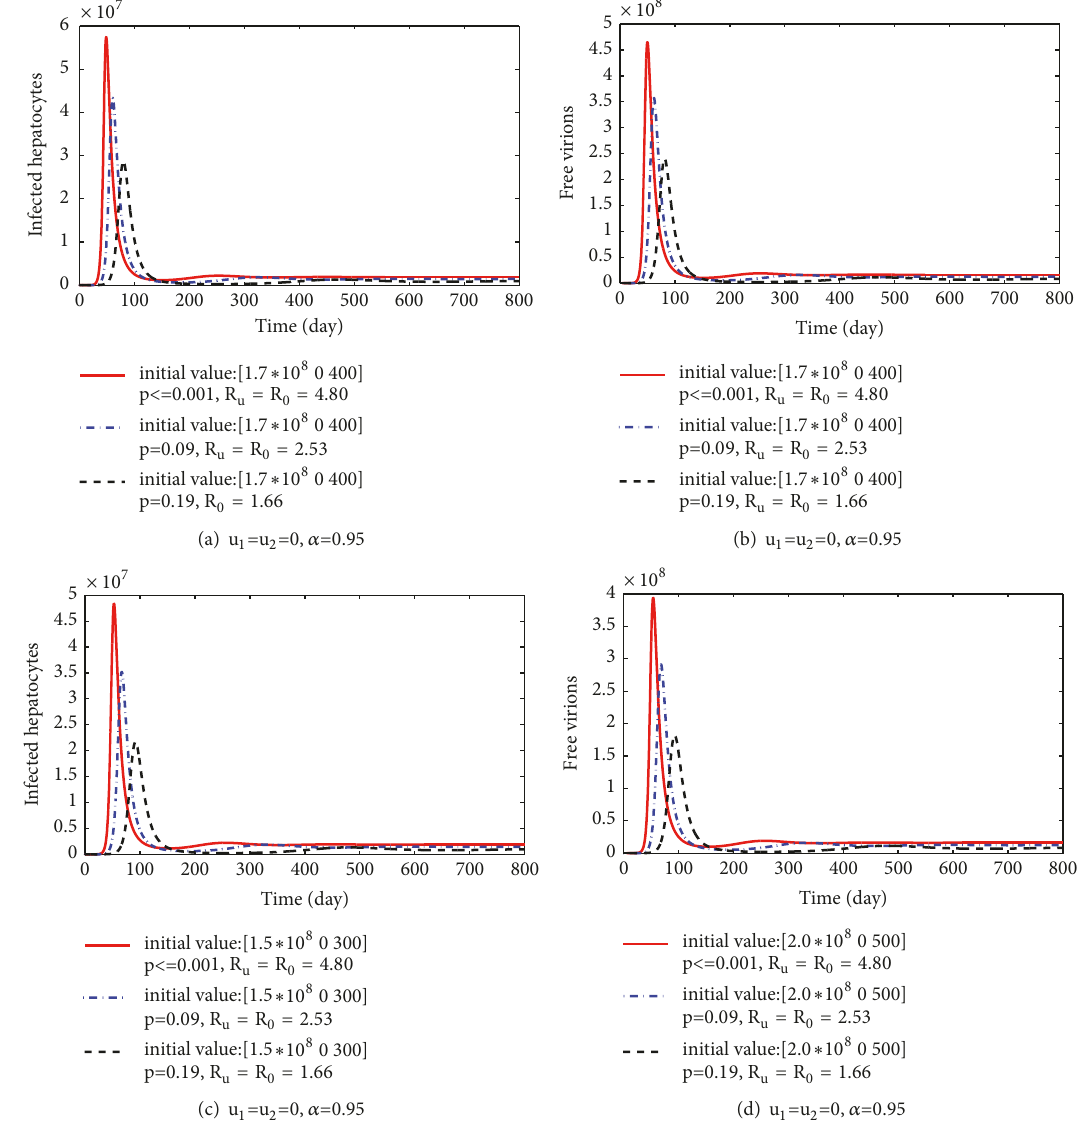
Figure 2: Dynamics of system (3) for different values of 𝑝 , which shows that the disease-free equilibrium 𝐸 0 𝑢 = (Π/𝛿, 0, 0) = (1.667×10 8 ,0,0) is unstable when 𝑅 𝑢 = 𝑅 0 > 1 , where 𝛼 = 0.95 . The initial conditions of (a) and (b) are as follows: [ 1.7 × 10 8 0 400]; the initial conditions of (c) and (d) are as follows: [ 1.5 × 10 8 0